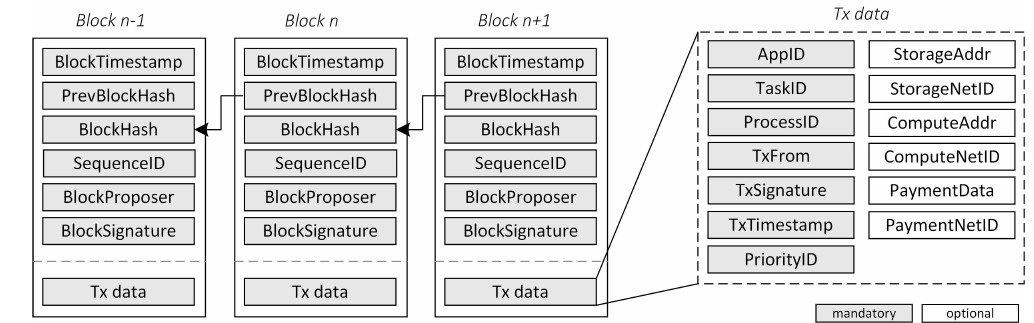
Figure 2. The block dan transaction data structure in the Core Engine. The grey blocks are mandatory components while the white ones are